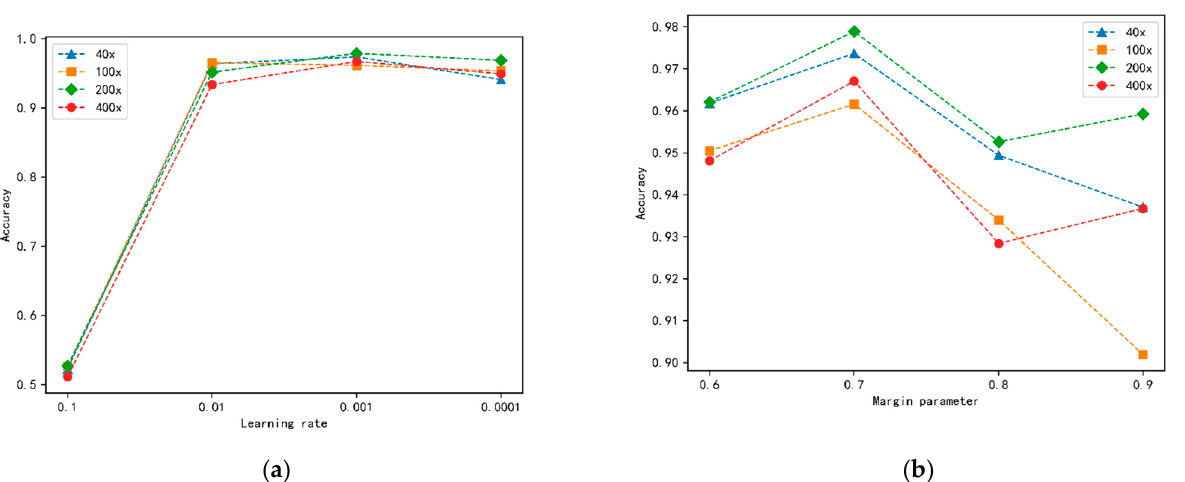
( b ) Figure 9. ( a ) Single-scale input-image accuracy; ( b ) Multi-scale input-image accuracy. Comparison of the classification accuracy of multi-scale input-image method with single-scale input-image on four different magnifications database. At 40×, 100×, 200×, and 400× magnification, the input of 1× + 2×, 0.5× + 1×, 0.25× + 0.5×, and 0.125× + 0.25× achieved a higher recognition effect, respectively. Therefore, the subse- quent experiment used those settings. Owing to the different image magnifications, their original scale was also different, and consequently the best input scale combination also varies. As seen in Figure 9, the optimal input scale is continuous. This indicates that there is a universal optimal image scale for breast cancer histological image classification.